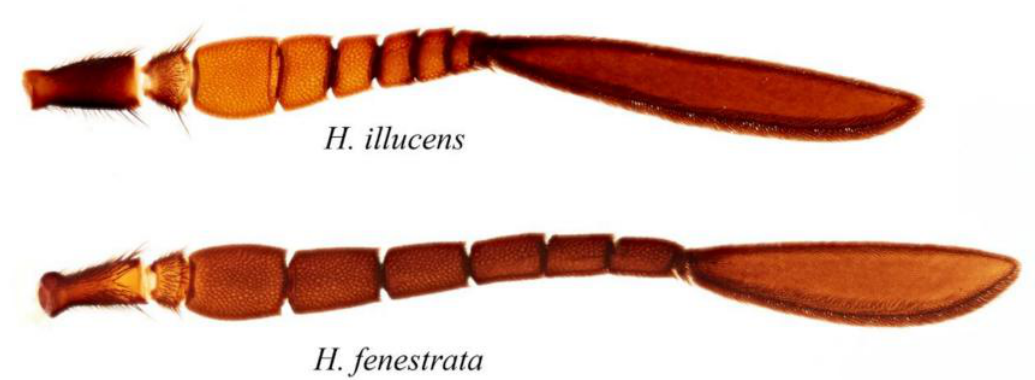
Figure 7. Detail of the female antennae of the adult Hermetia illucens and H. fenestrata .